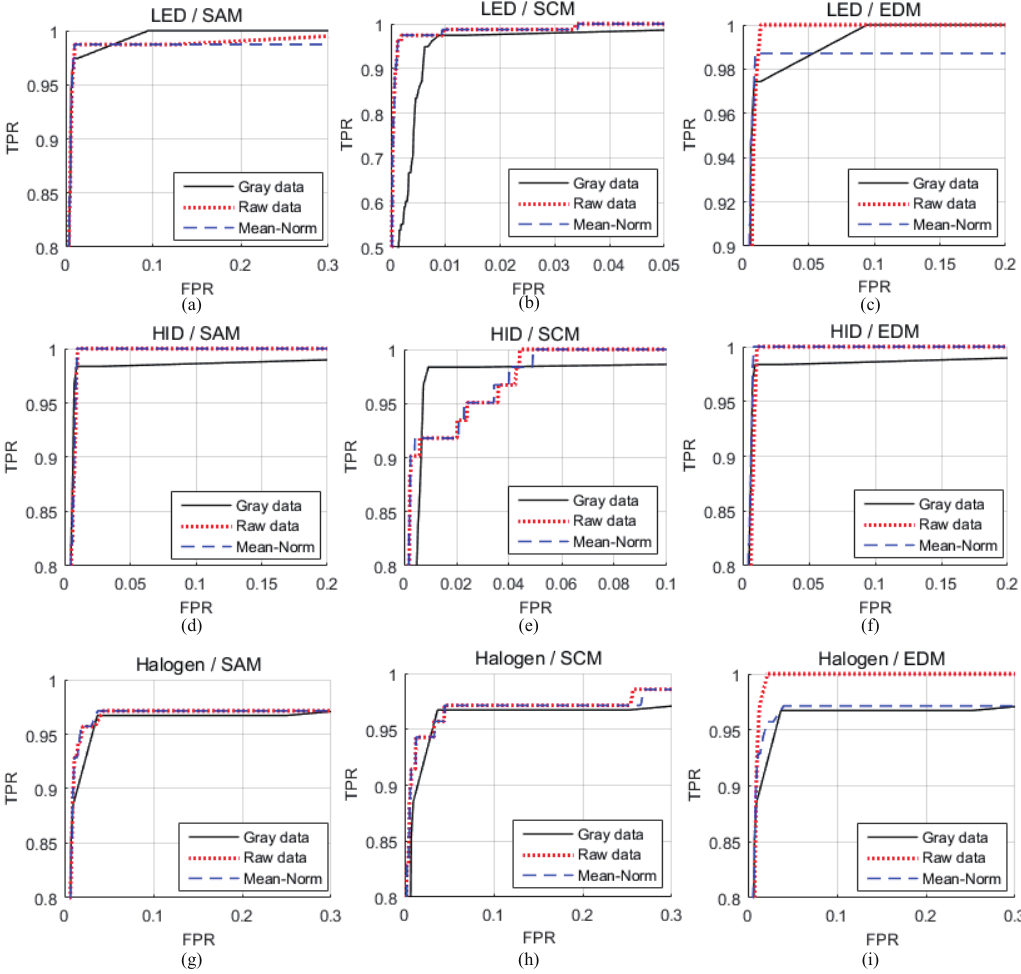
Figure 10. ROC in each combination methods ( a ) using the SAM detection metric in a LED headlight ( b ) using the SCM detection metric in a LED headlight ( c ) using the EDM detection metric in a LED headlight ( d ) using the SAM detection metric in a HID headlight ( e ) using the SCM detection metric in a HID headlight ( f ) using the EDM detection metric in a HID headlight ( g ) using the SAM detection metric in a halogen headlight ( h ) using the SCM detection metric in a halogen headlight ( i ) using the EDM detection metric in a halogen headlight.